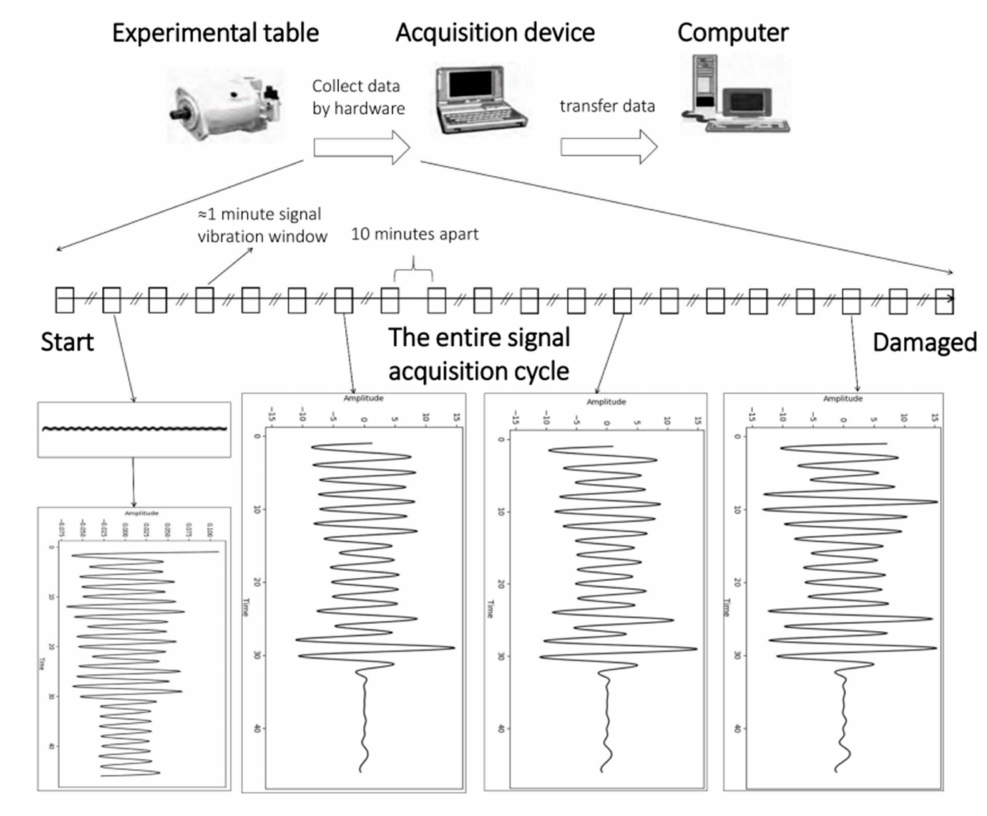
Figure 4. Experimental bench and signal acquisition.